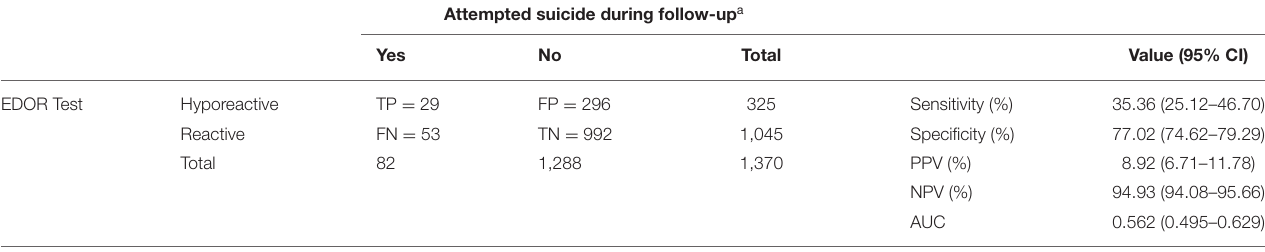
TABLE 4 | Sensitivity, specificity, and AUC of ElectroDermal Orienting Reactivity (EDOR) test and suicide attempt during follow-up.